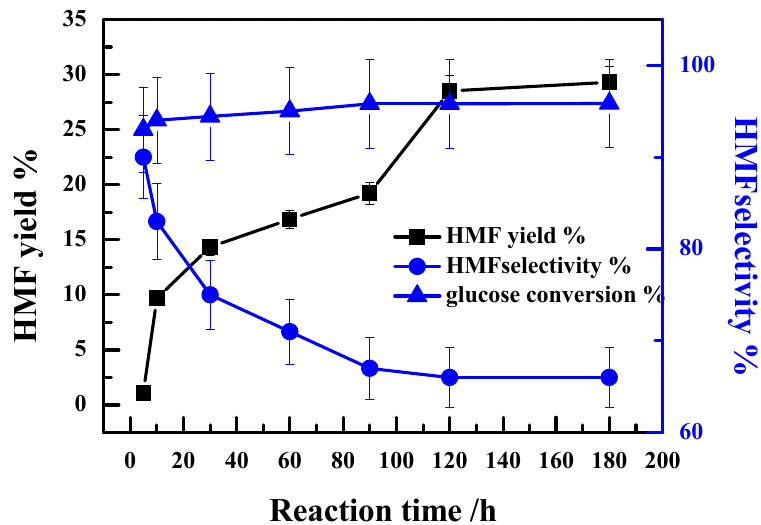
Figure 3. Effect of reaction time on glucose dehydration Reaction conditions: 0.15 ZrOCl 2 , 0.15 g [HO 2 CMMIm]Cl, 0.1 g glucose, 3.0 g isopropanol, 150 °C reaction temperature.